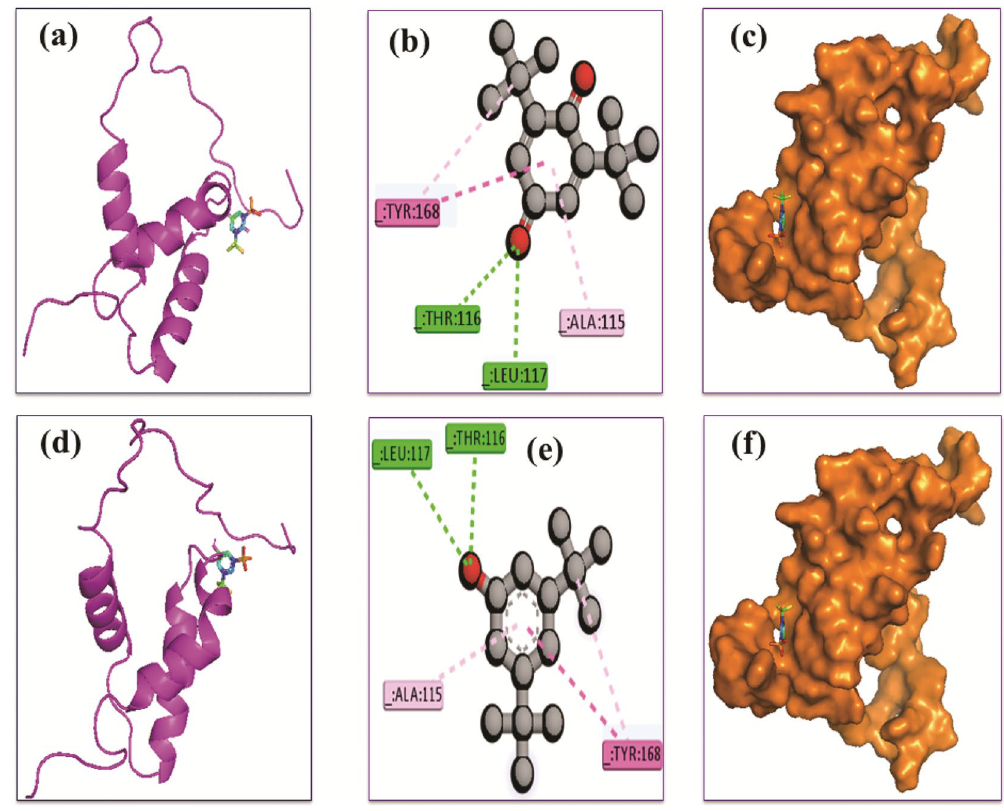
Figure 10. Docking simulation between MYB gene and 2,6-ditert-butylcyclohexa-2,5-diene-1,4-dione and 3,5-ditert-butylphenol, respectively, as a ( a ) cartoon view, ( b ) 3D view, ( c ) surface view of CID: 12,867 where ( d )